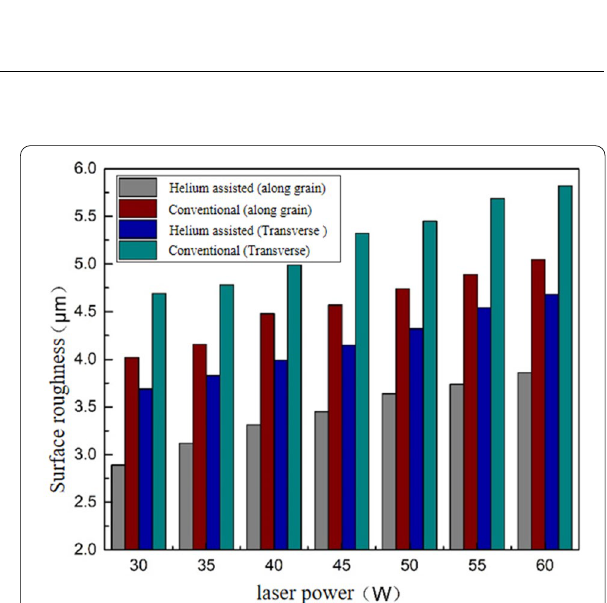
Fig. 9 Influence of laser parameters on surface roughness during transverse